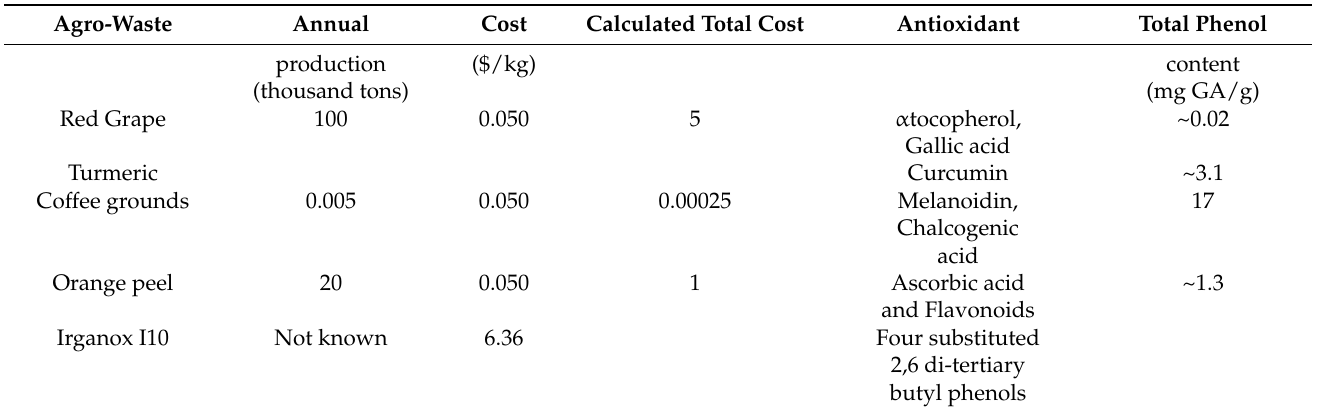
Table 3. Cost of recovering antioxidants from selected agro-wastes and the phenol content